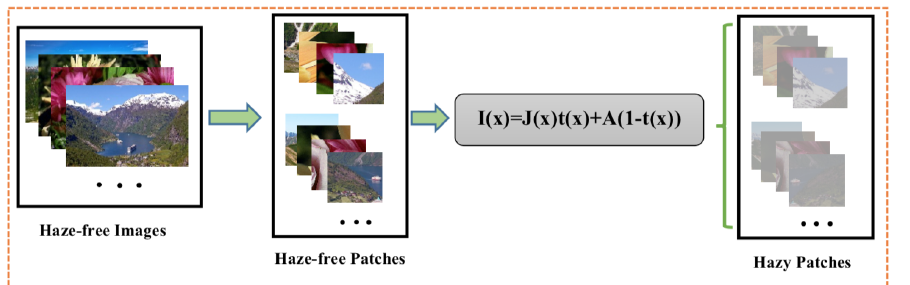
Figure 10. Learning Process